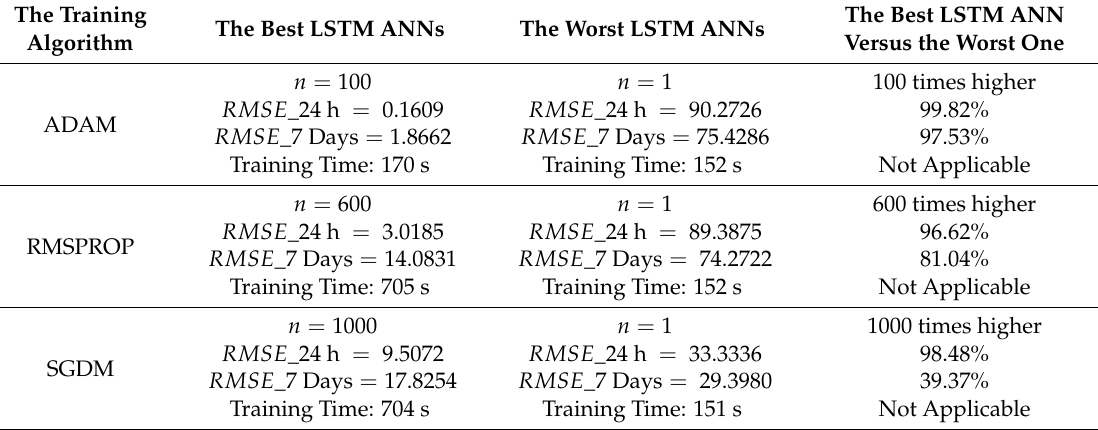
Table 3. The LSTM forecasting ANNs and their corresponding performance